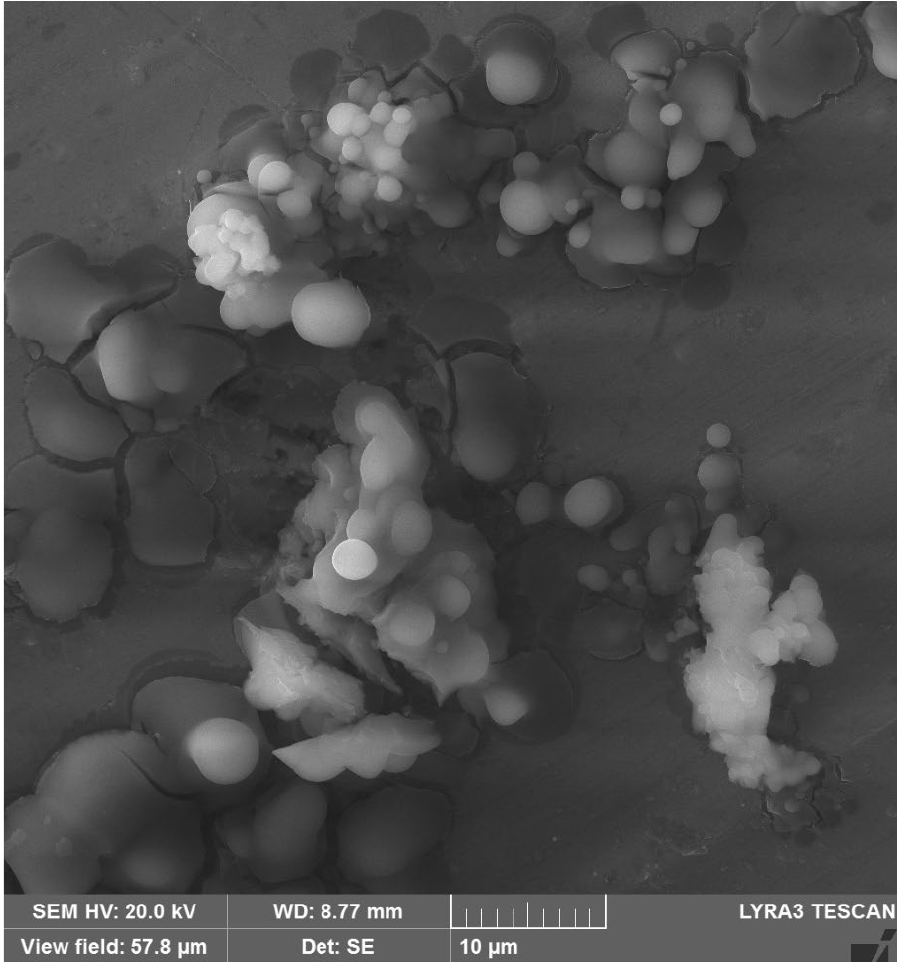
Figure 6. FE-SEM image of CHT − CuO nanocomposite. The XRD, SEM, TEM, and DLS analysis results were similar for all the nanocom- posites prepared in the presence of varying amounts of chitosan. This suggests that the concentration of chitosan did not influence the quality of nanoparticles